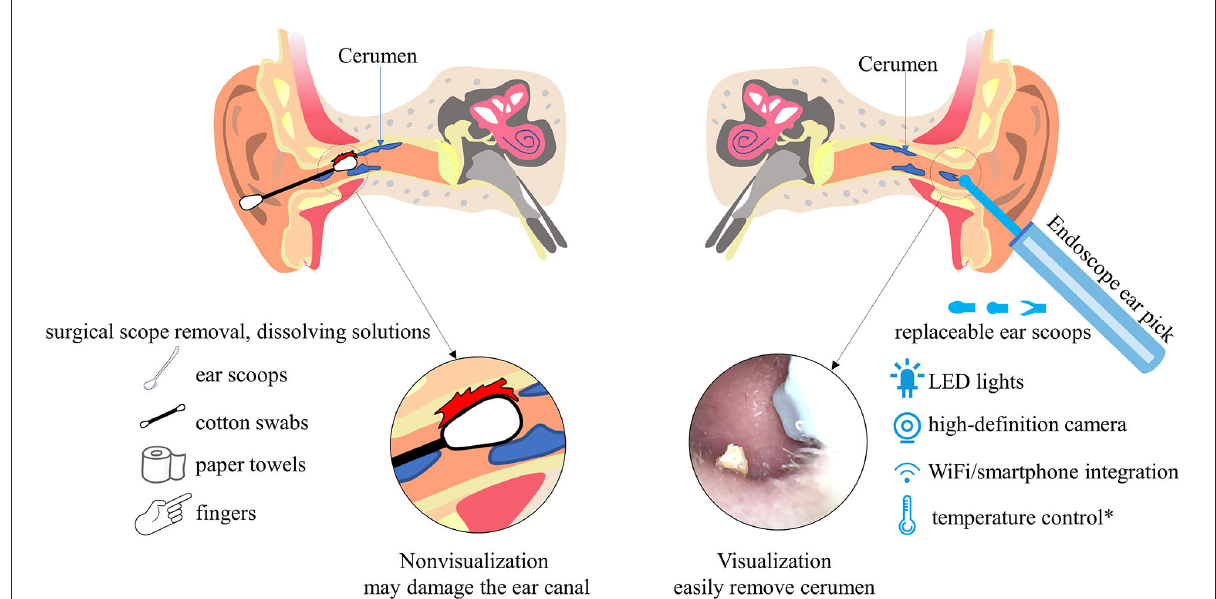
FIGURE1 The location and general concept behind cerumen removal: From the traditional way to the Endoscope ear pick. *Most Endoscope ear picks are equipped with replaceable ear scoops, LED lights, high-definition cameras, and WiFi/smartphone integration. Only a few can control the temperature and maintain a constant